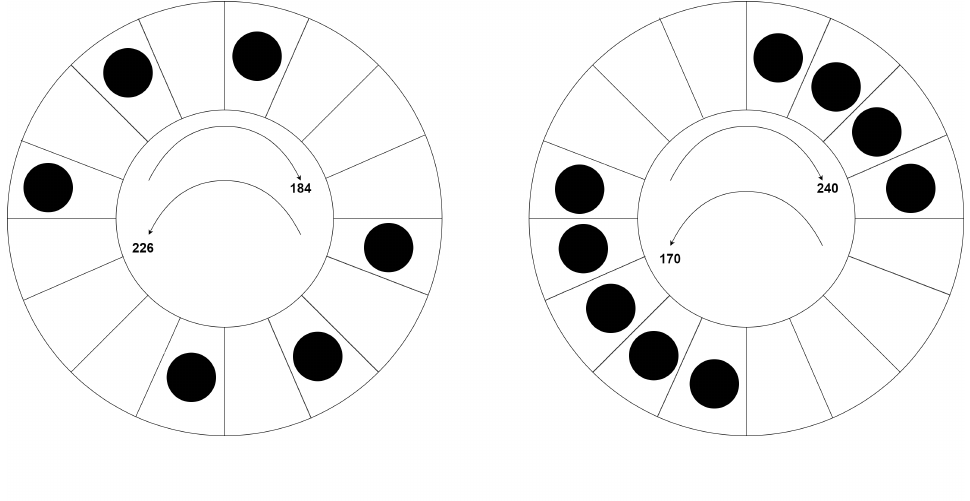
Figure 2. ( Left ): Circle movement with rules ECA 184/226. ( Right ): Cluster movement ECA 240/170. ECA 136 and ECA 252 can be also used for traffic modeling